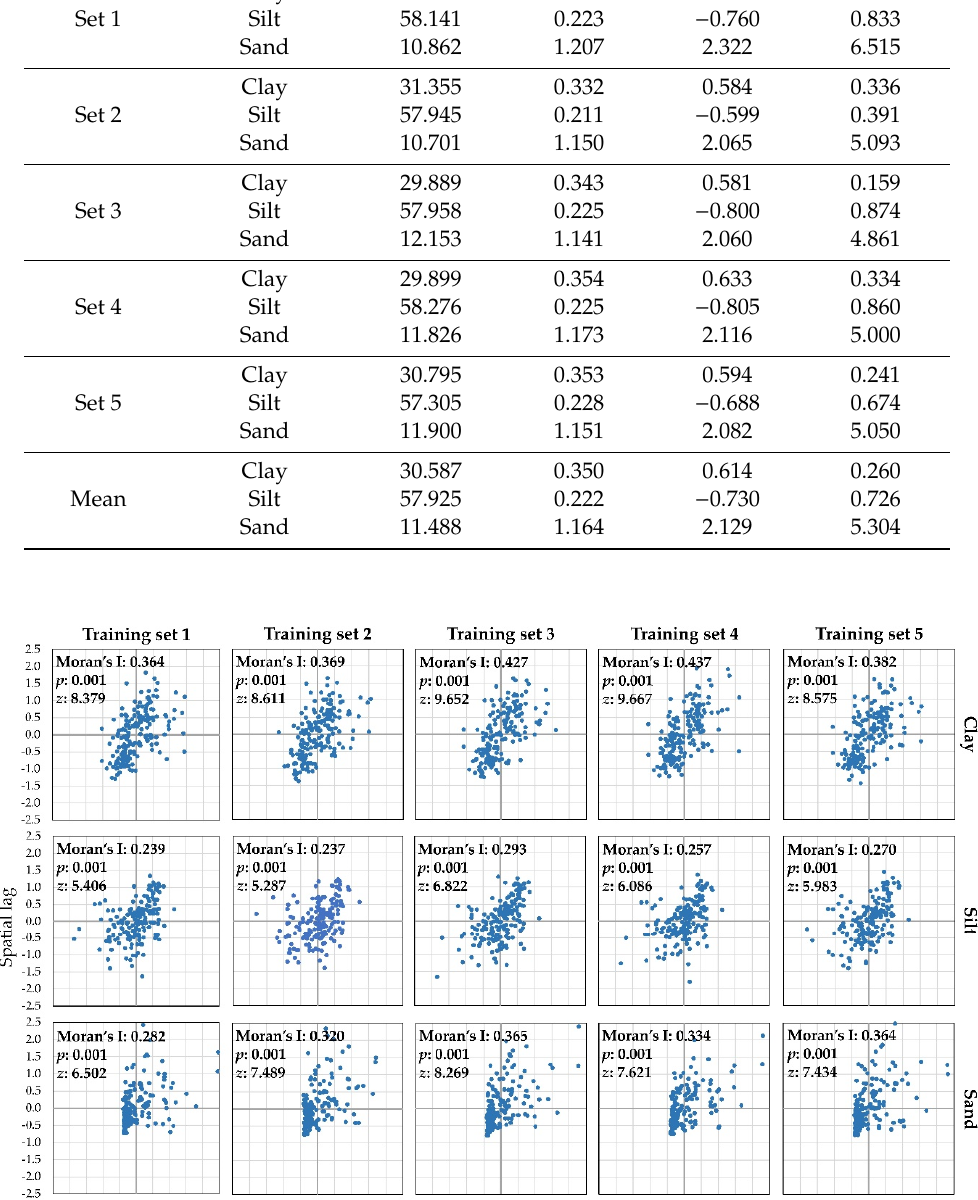
Table 3. Descriptive statistics of random training sample sets.